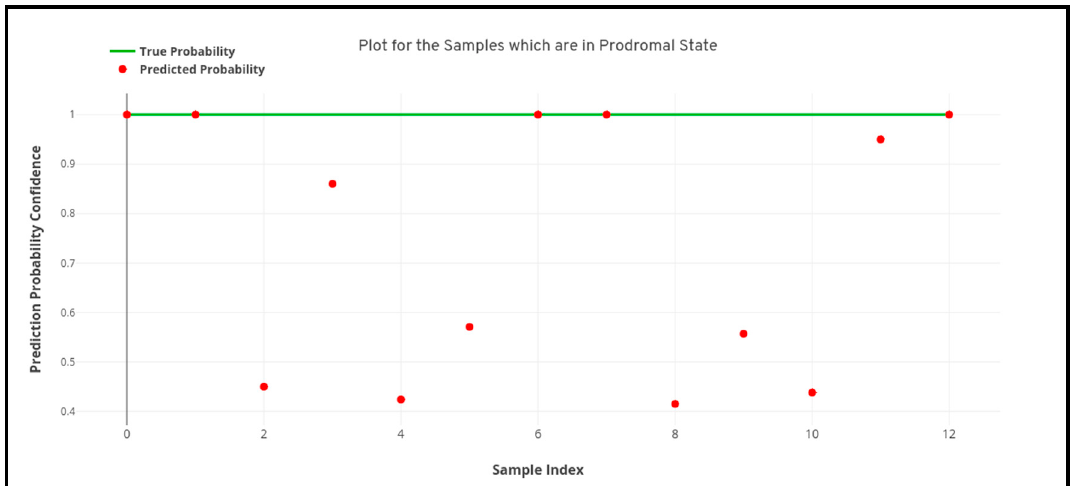
Figure 8. Quantile-quantile plot between the true probability and the prediction probability of the samples belonging to the control class. Probabilistic confidence is 0.82.